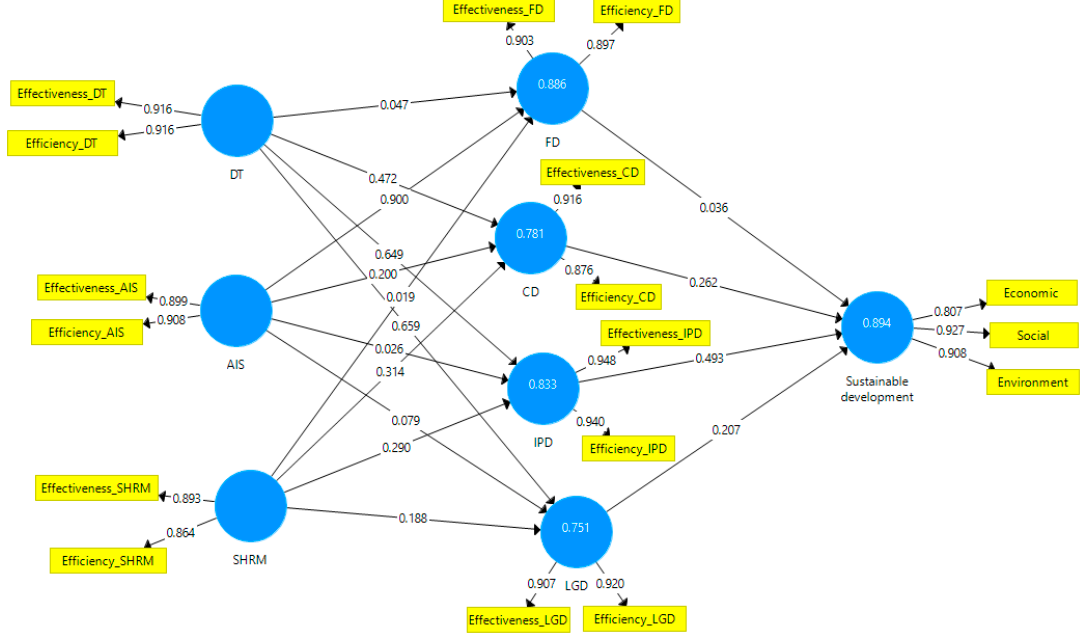
Figure 3. Empirical model. Source: own construction using SmartPLS v3.0 (SmartPLS GmbH, Oststeinbek, Germany). over 0.8, Composite Reliability over 0.8, and average variance extracted over 0.6 [108]. Moreover, values below 0.08 (0.074) for SRMR (standardized root mean squared residual) and values over 0.9 (0.904) for NFI (normed fit index) prove a good fit for the model.